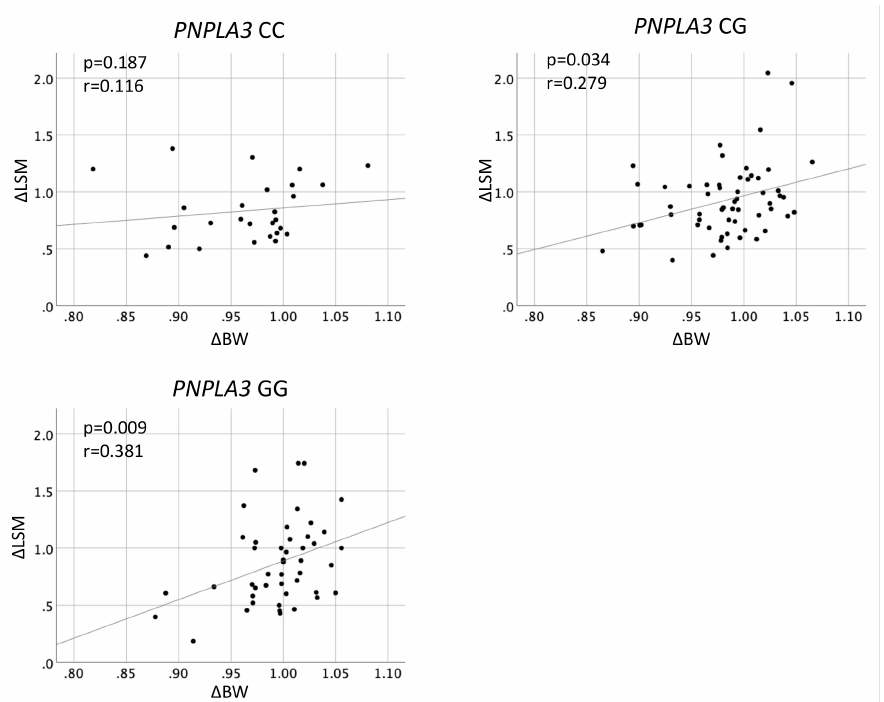
Figure 2. Correlation between changes in body weight and in liver stiffness measurement according to PNPLA3 rs738409 genotypes in 140 patients with non-alcoholic fatty liver